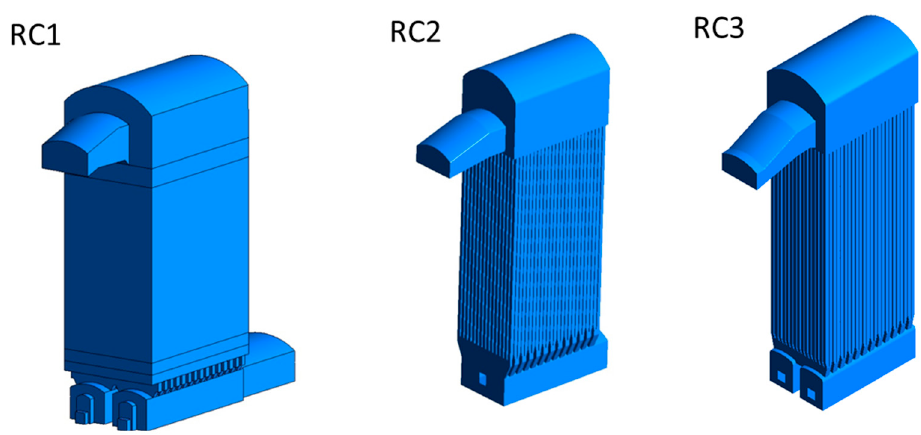
Figure 4. Tested regenerative chambers. Table 1. Geometrical parameters of the tested regenerative chambers.